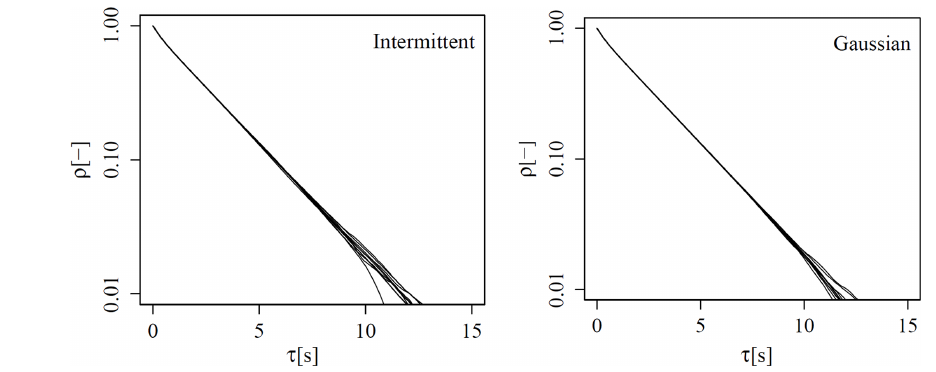
Figure 3. Correlation coefficient ρ over lag value τ for 10 Gaussian and 10 intermittent realizations.